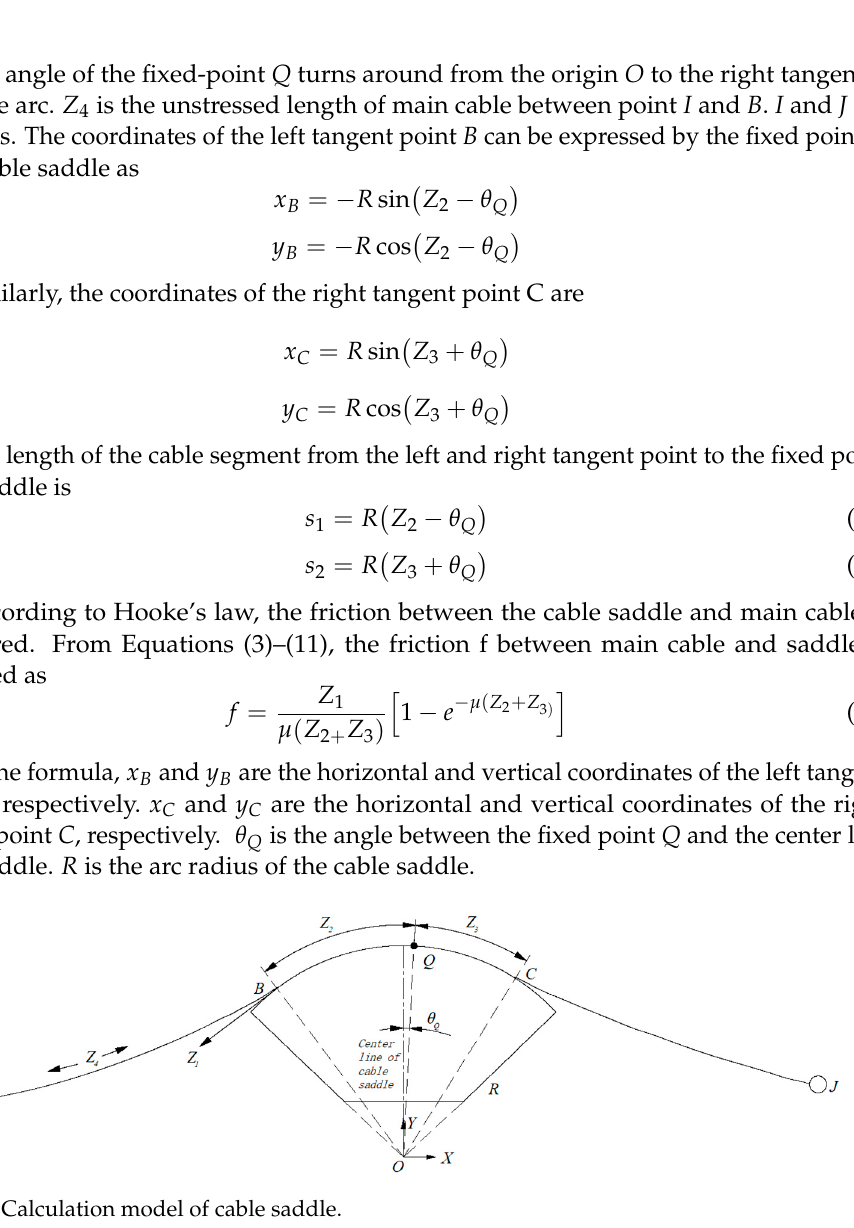
Figure 5. Calculation model of cable